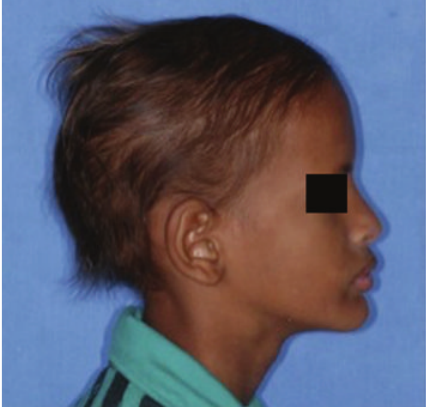
Figure 1: Facial profile view: sparse and fine hair, frontal bossing, high-set orbits, pronounced chin, prominent and reverse lips, sunken cheeks, and large and low set ears.